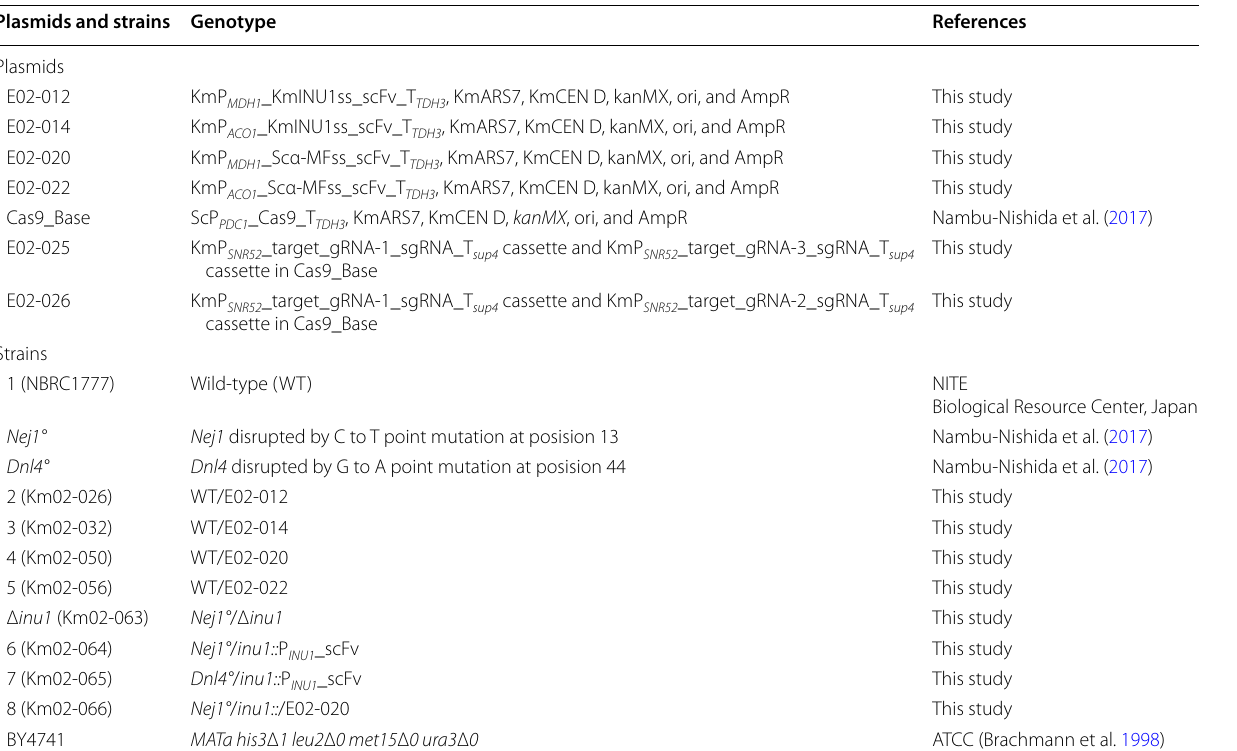
Table 1 Plasmids and strains used in this study Plasmids and strains